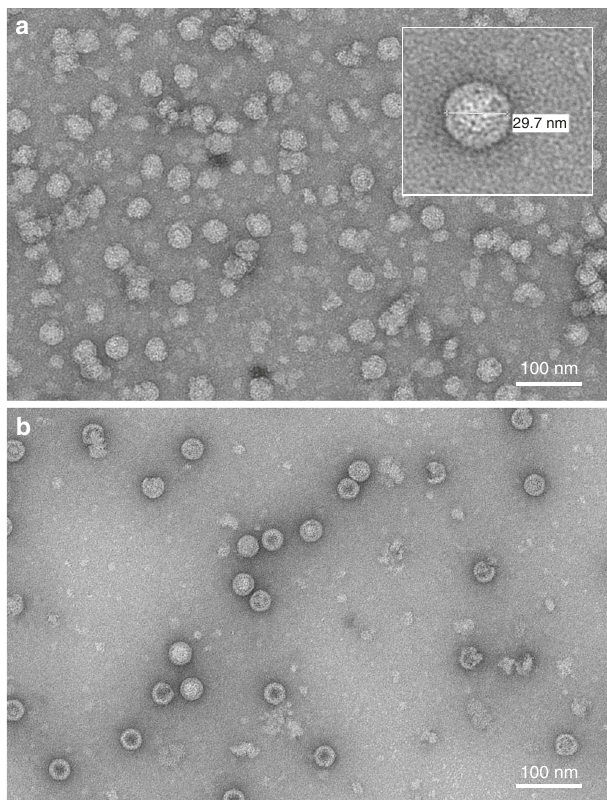
Fig. 2 Electron microscope analysis of plant-produced PV